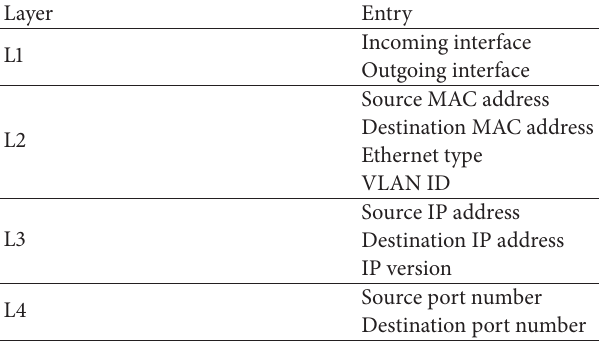
Table 2: The constitution of conditions for capturing